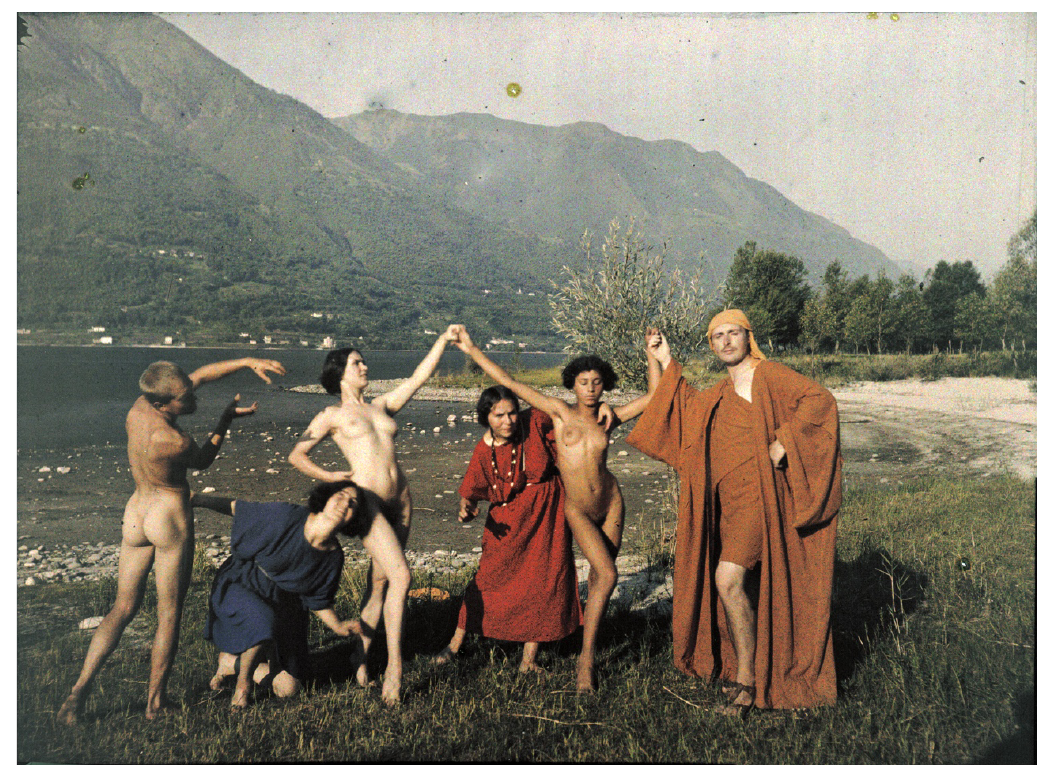
Figure 4. Rudolf Laban and the performance of free dances at the Monte Verità in Ascona (Switzerland), 1914. Source: Johann Adam Meisenbach